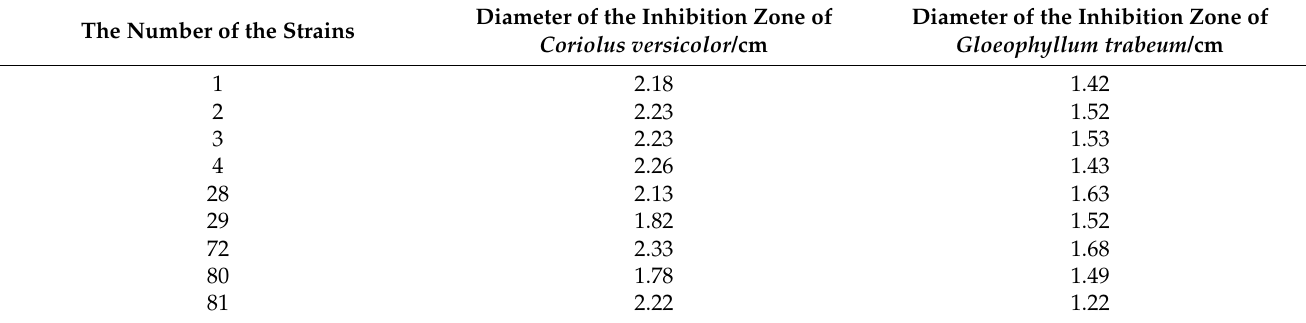
Table 1. Diameter of the inhibition zone of the strains against Coriolus versicolor and Gloeophyllum trabeum . Diameter of the Inhibition Zone of Diameter of the Inhibition Zone of The Number of the Strains Coriolus versicolor /cm Gloeophyllum trabeum